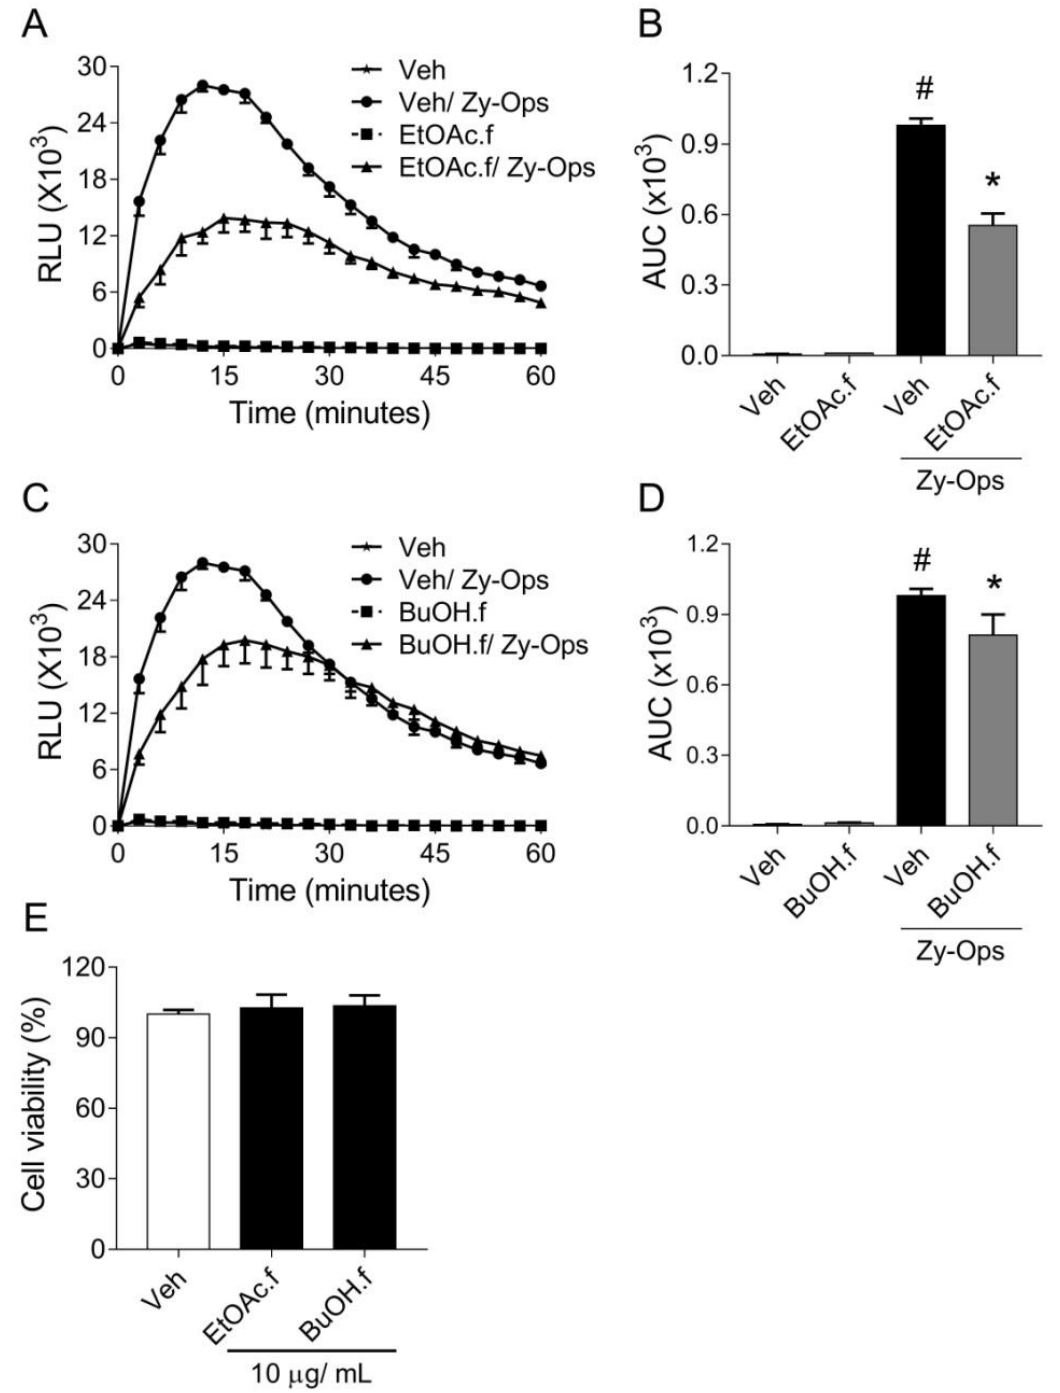
Figure 2. Pretreatment with EtOAc.f and BuOH.f reduces opsonized zymosan-induced production of ROS by BMDMs. ( A – D ) BMDMs were pretreated for 30 min with 10 µg/mL of EtOAc.f or BuOH.f following Zy-Ops stimulus (100 µg/mL); ( A , C ) are representative curves of ROS production over time; and ( B , D ) represent the area under the curve (AUC) as quantification of ROS. Each group was analyzed in triplicates. ( E ) Cell viability determined through MTT assay calculated as the percentage of untreated cell group (Veh). Data represent mean ± S.E.M. of triplicates of one representative experiment. # and * indicate statistically significant difference comparing to Veh group or Zy-Ops group, respectively, p < 0.05.